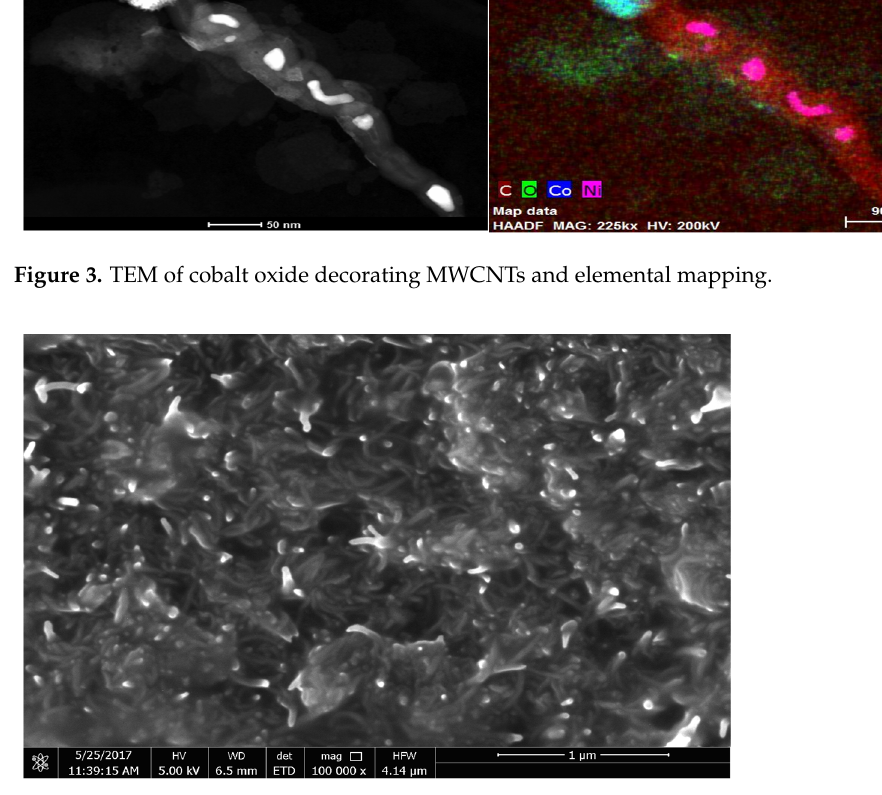
Figure 4. SEM of MWCNs impregnated in PU matrix.